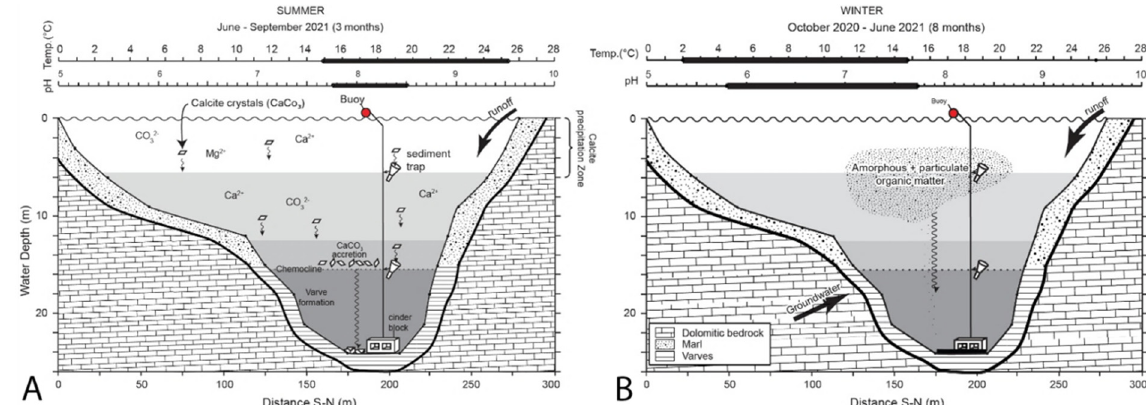
Figure 2. Range of temperature and pH measured during summer ( A ) and winter ( B ) through the water column of Crawford Lake during the 2021 hydrological year (shown on scales above images).